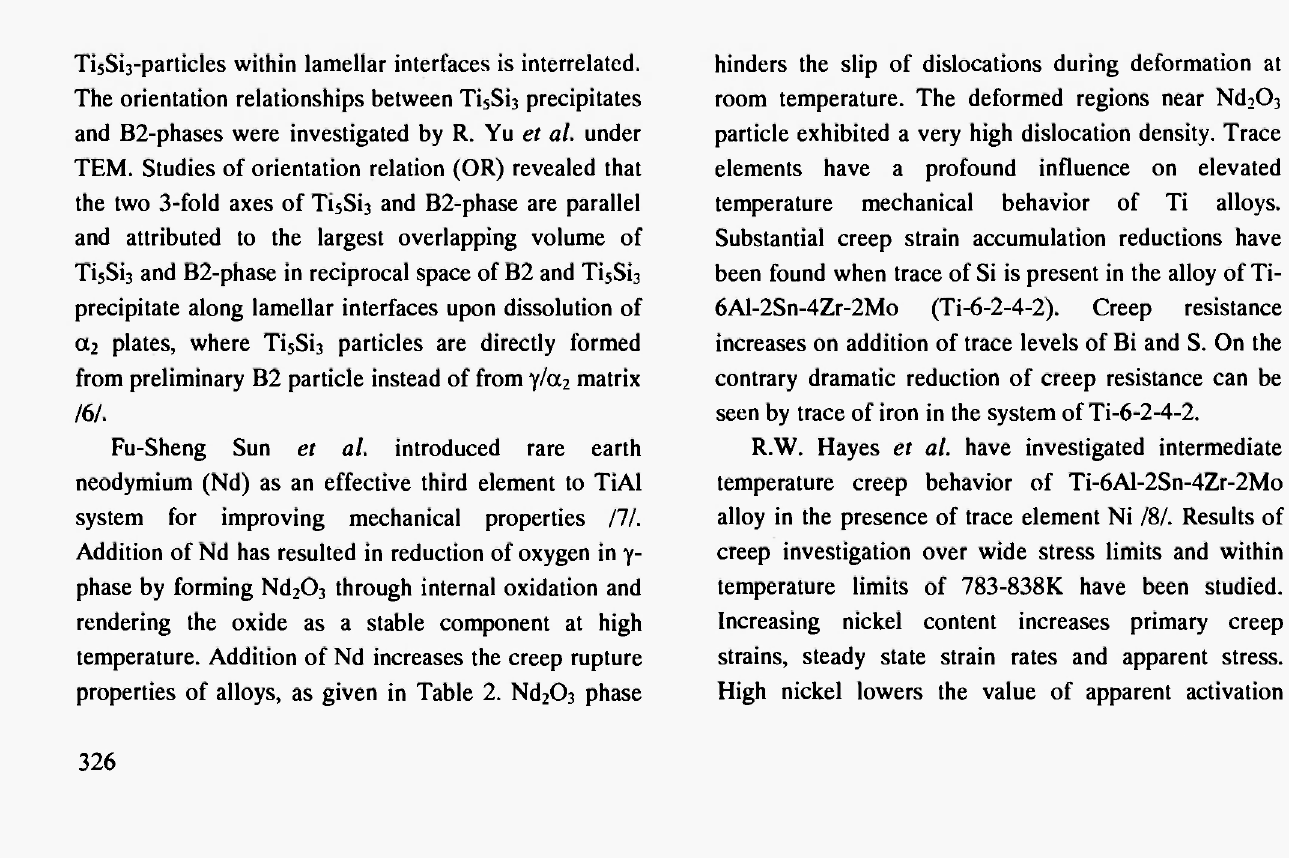
Tensile properties and creep rupture properties of TiAl alloys